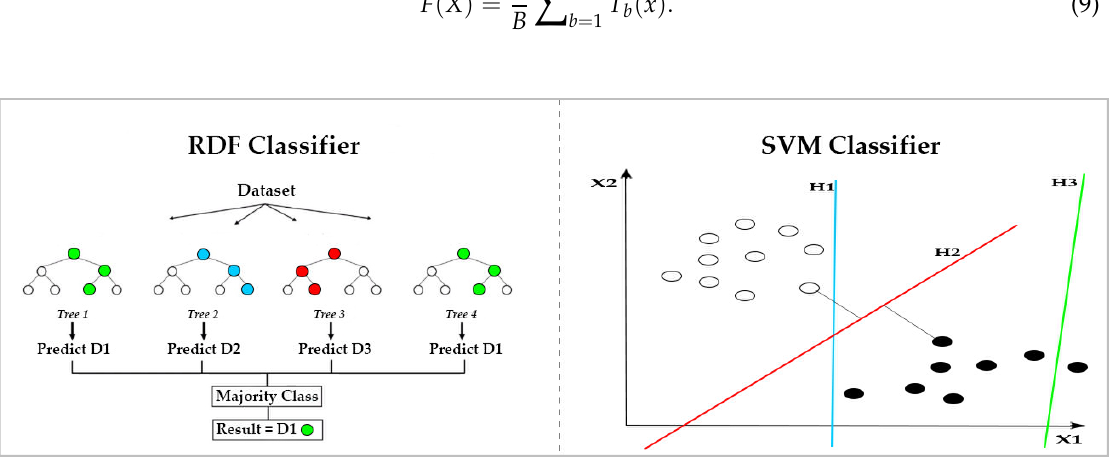
Figure 4. Classification process of random forest (RDF) in ( left ) and support vector machine (SVM) in ( right ).